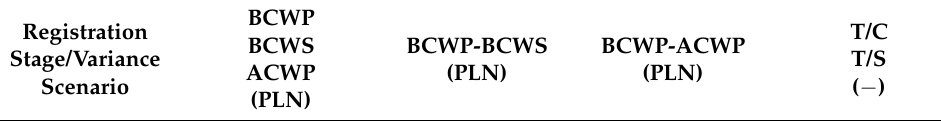
Table 1. Schedule models according to the method of parallel execution. Source: [19].